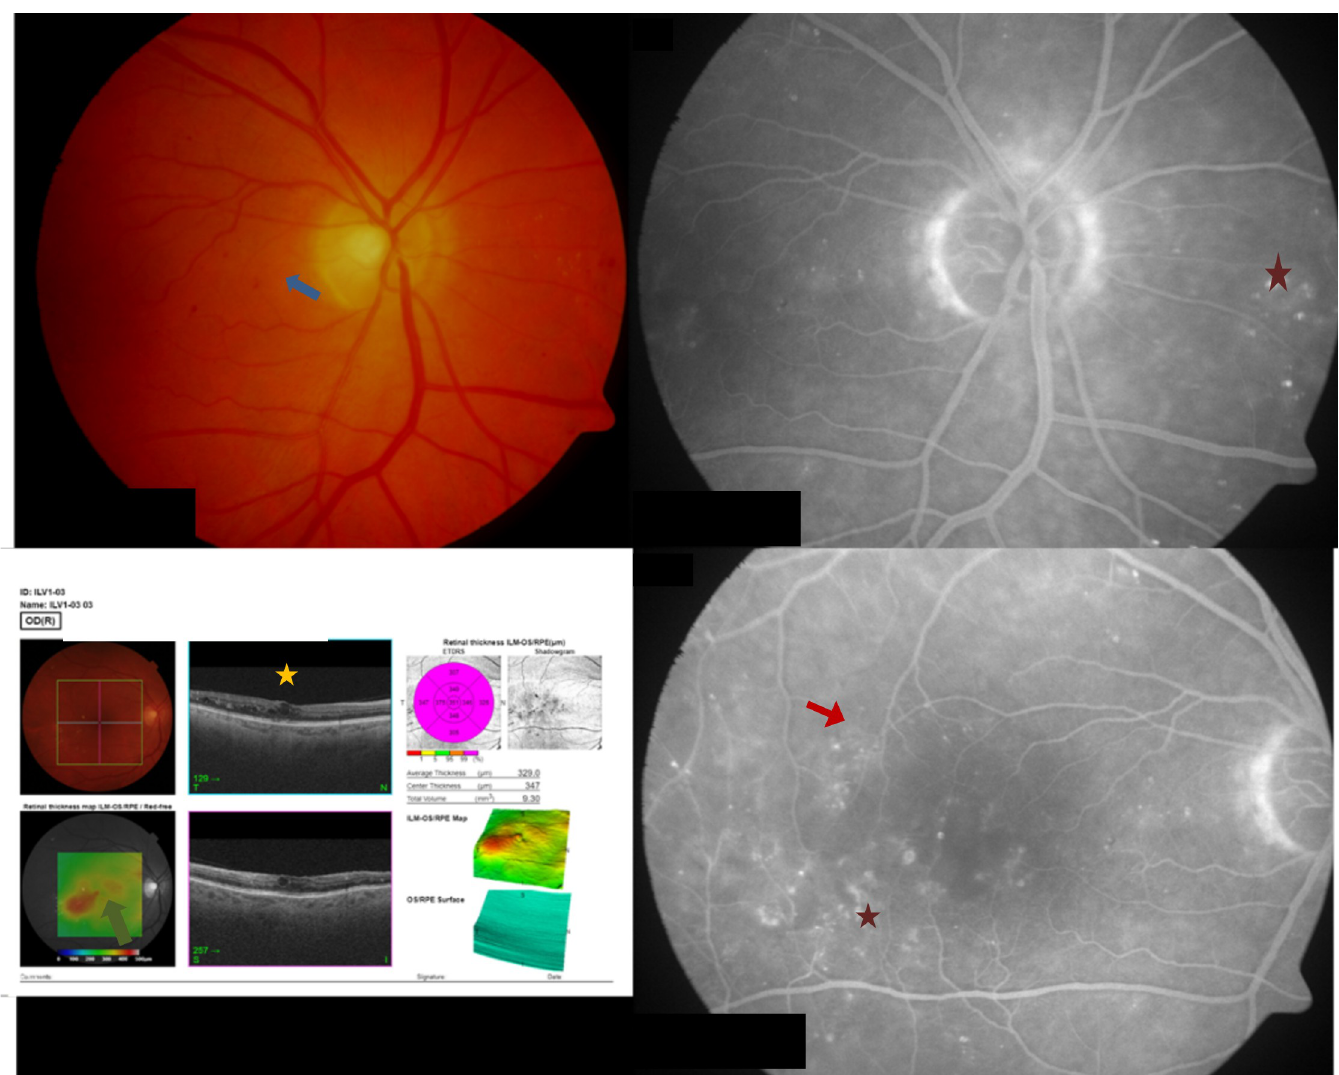
Fig 2. A case from a patient with moderate NPDR at screening. Image notes: (1) Top-left panel shows a fundus photo and reveals a few small dotted bleedings spots . (2) Bottom-left panel shows an optical coherence tomography (OCT) image of intraretinal cysts with exudates and mild edema in the inferior temporal region. (3) Right panels show fluorescin angiography images from a normal optic disc, a mild intraretinal microvascular anomaly and several microaneurysms